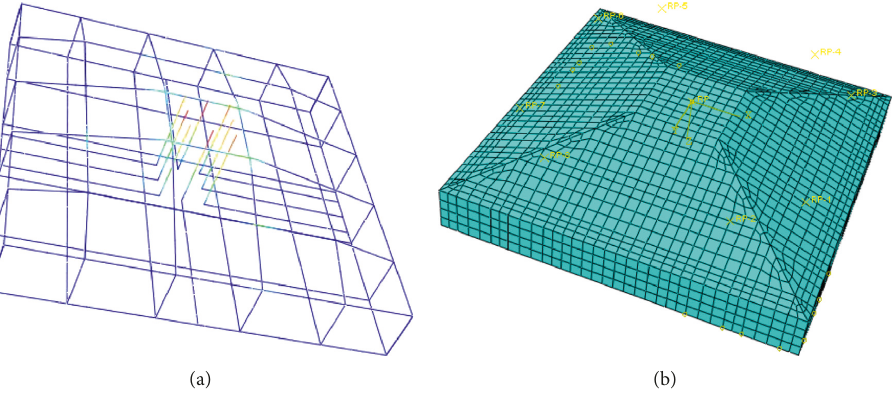
Figure 9: Finite element model for the spread foundation slab. (a) Steel reinforcement. (b) Concrete foundation slab.